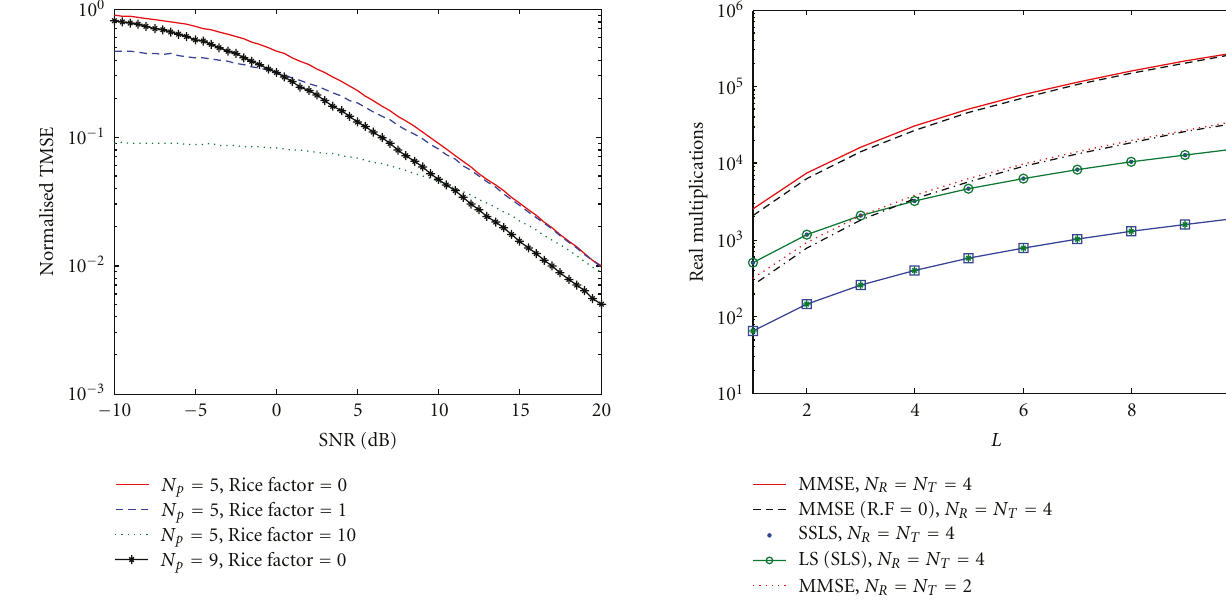
Figure 3: Normalized TMSE of the MMSE estimator in the Rayleigh and Rician fading channels ( N T = N R = 2, L = 1, N P = 5,9).